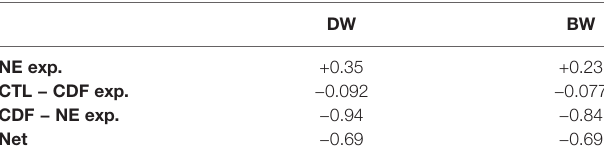
TABLE 1 | Changes in the dissolved oxygen (DO) concentration (ml l − 1 ) over the 36-year period (1980 to 2015) obtained from the no-ecosystem (NE) experiment, difference between the control (CTL) and the constant detritus fl ux (CDF) experiments, and difference between the CDF and the NE experiments at each depth range from 1618 to 2250 m (deep water: DW) and from 2250 m to the bottom (bottom water: BW),